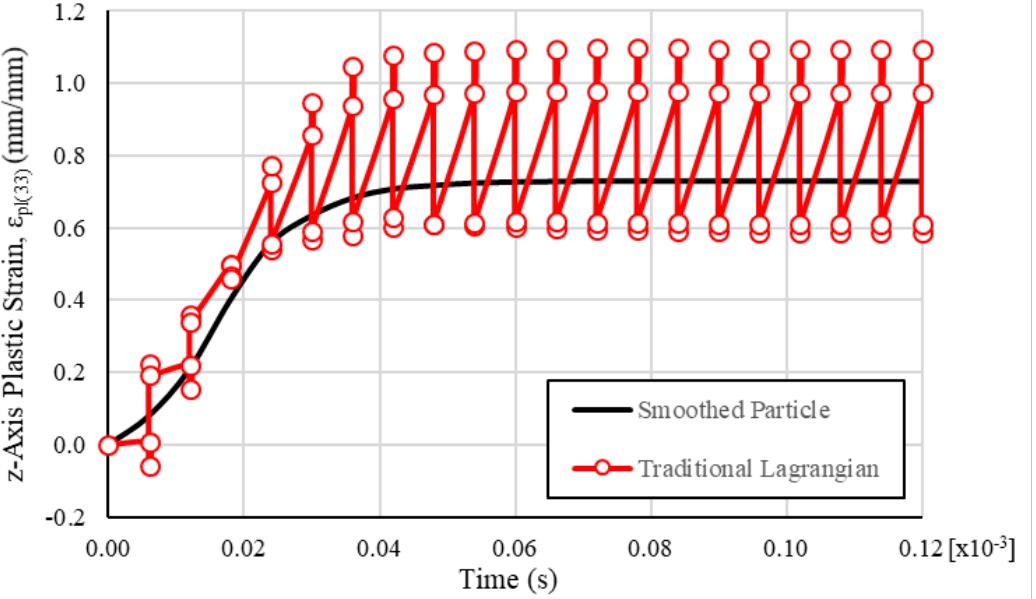
Figure 16. Comparison of Plastic Strain along the Impact Axis between Traditional Lagrangian Finite Element and Smoothed Particle Hydrodynamics